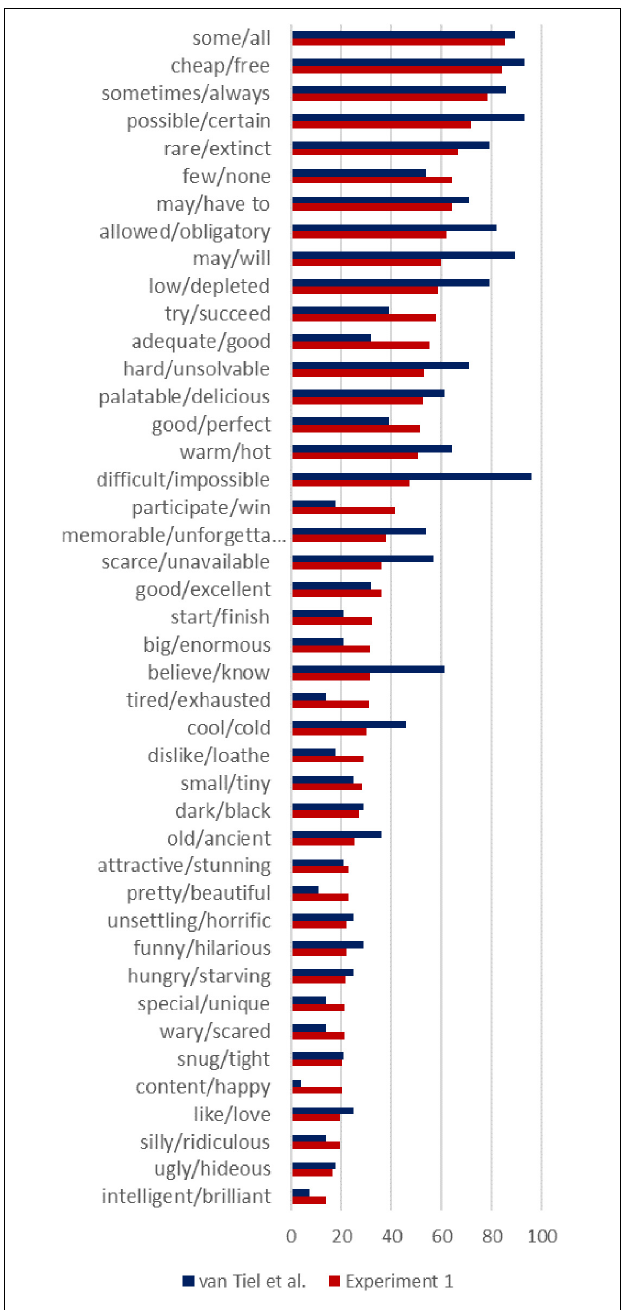
FIGURE 2 | Mean inference ratings for Experiment 1. The rates of SIs from van Tiel et al. (2016) Experiment 2 are shown in blue bars.